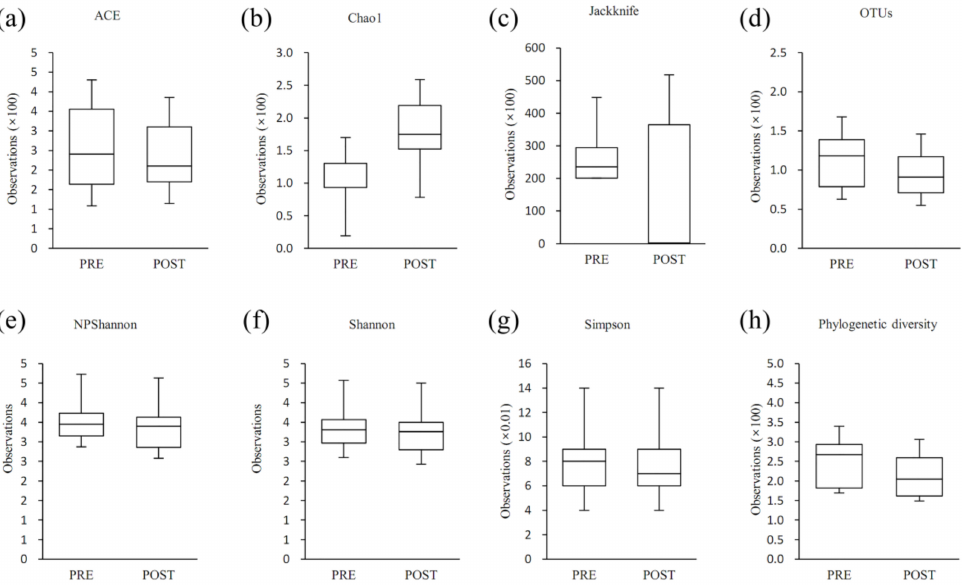
Figure 6. Alpha diversity index for salivary microbiome of cancer patients. Species richness was analyzed based on ( a ) Ace ( b ) Chao1, ( c ) Jacknife, and ( d ) OTU. Species diversity was analyzed as ( e ) NPShannon, ( f ) Shannon, ( g ) Simpson, and ( h ) Phylogenetic diversity. The analysis results are presented as a boxplot, with the horizontal black band representing the median value and the upper and lower margins of the boxplot representing the first and third quartiles. No statistically significant differences were detected between the two groups in any of the analyzes